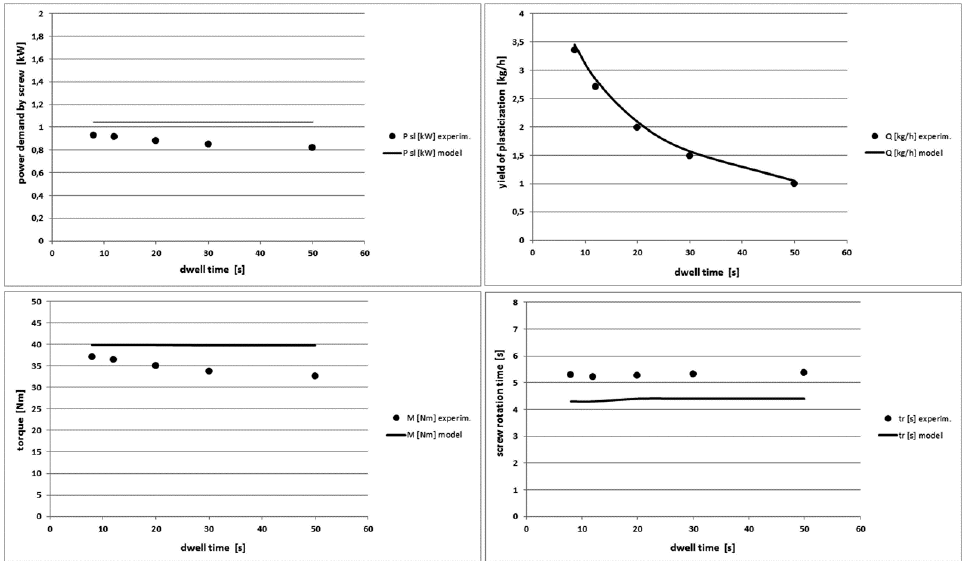
Figure 13. Comparison of other theoretical and experimental characteristics for different dwell time values in PE-HD injection process.